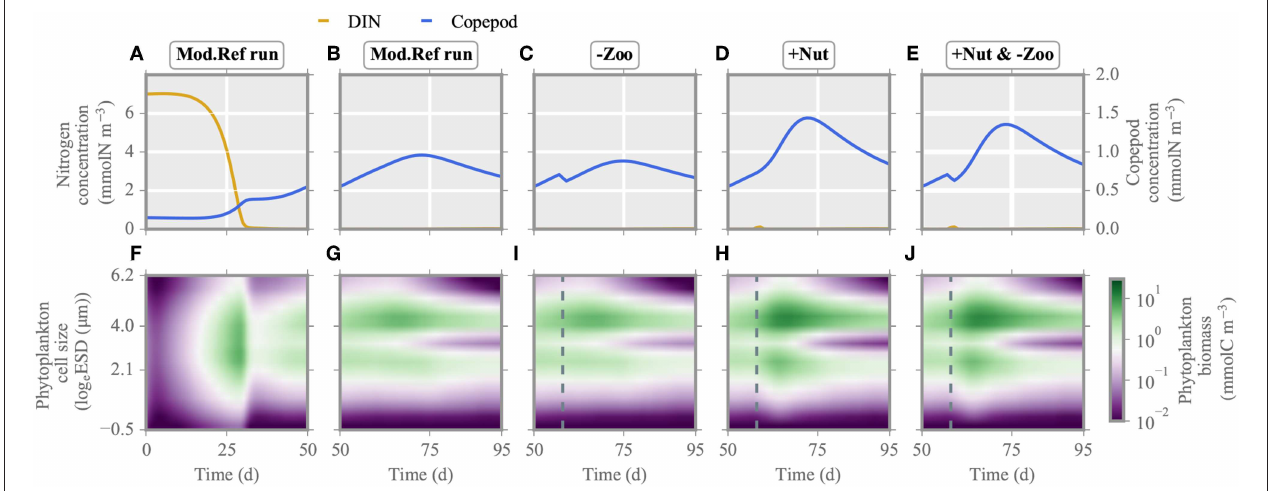
FIGURE 5 | Multi-species model: nitrogen concentration, copepod biomass (A–E) and phytoplankton biomass distribution (F–J) under single/multiple stressors. Analogous to Figure 4 , the reference run is shown for the first (A,F) and second half of the experiment (B,G) . The two single/multiple stressors grazer removal (-Zoo, C,I ) and nutrient enrichment ( + Nut, D,H ) are combined in the multiple stressor experiment (E,J) . Again, the dashed line indicates the time of stressor application. See Figure S2 for the mono-species